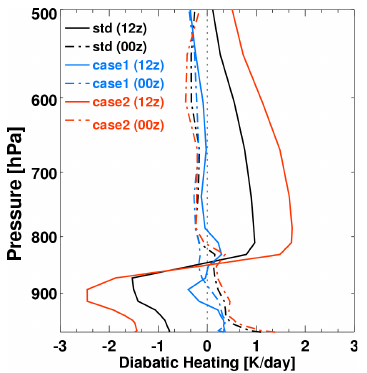
Figure 10 Dust impact on the equivalent potential temperature (ETH) profiles at 00 UTC 4 Fig. 10. Dust impact on the equivalent potential temperature (ETH) profiles at 00:00UTC and 12:00UTC averaged over the WAM re- and 12 UTC averaged over the WAM region (6 o N-17 o N and 15 o W-10 o E) from WRF-5 gion (6 ◦ N–17 ◦ N and 15 ◦ W–10 ◦ E) from WRF-Chem simulations Chem simulations in three cases with different dust absorption properties: std (ni=0.003), 6 in three cases with different dust absorption properties: std ( n i =0.003), case1 ( n i =0.0004), and case2 ( n i =0.006), where “ n i ” case1 (ni=0.0004), and case2 (ni=0.006), where ‘ni’ represents the imaginary part of the 7 represents the imaginary part of the refractive index of refractive index of dust. 8